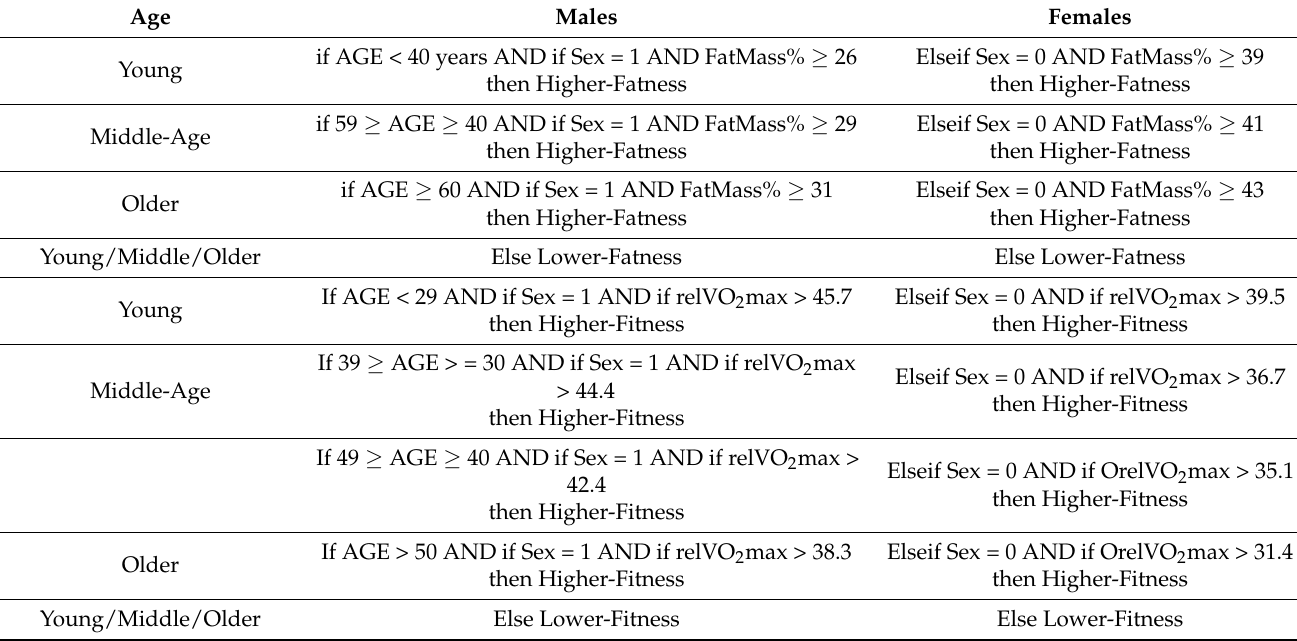
Table 1. Classification criteria for body fat percentage and relative VO 2 max (mL/kg/min), age and